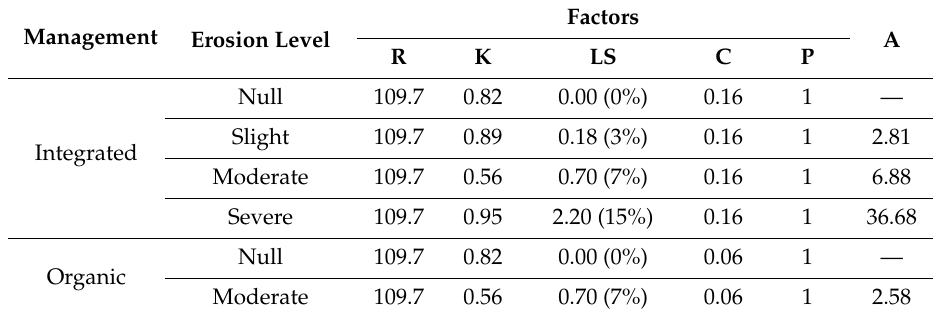
Table 2. Estimation of soil loss (A, t ha − 1 year − 1 ) and classification of the erosion levels of integrated and organic olive groves in the Estepa region according to the USLE